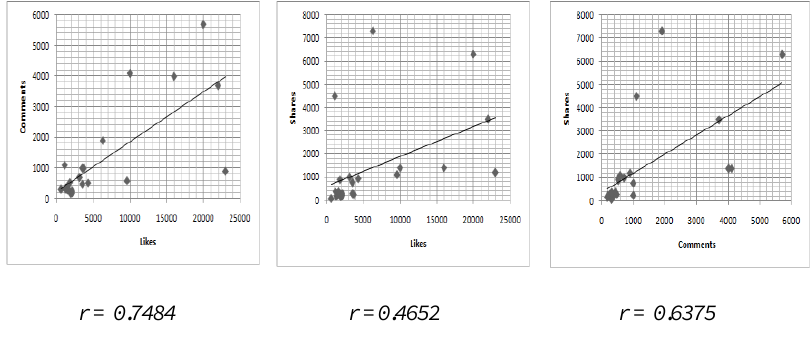
Fig. 9. Correlation Results for Page B